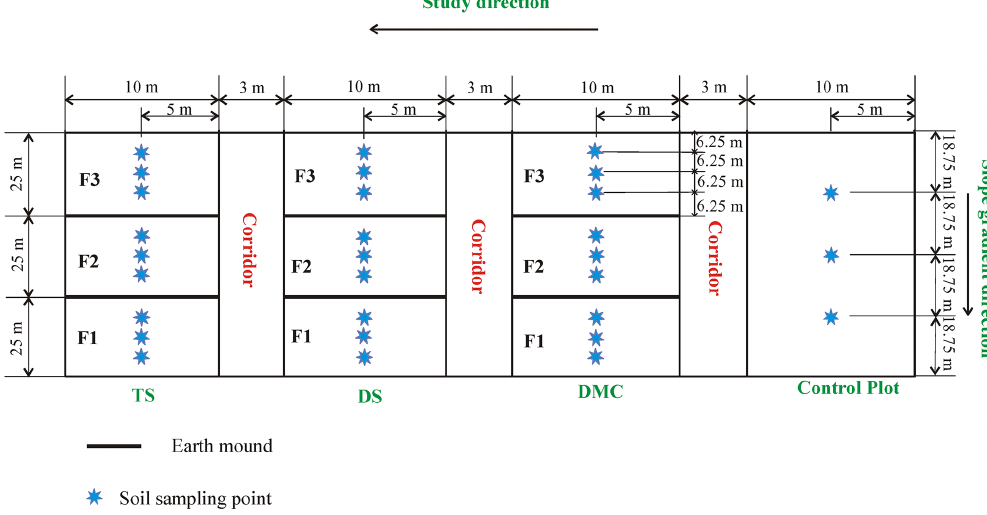
Figure 2. Study and soil sampling